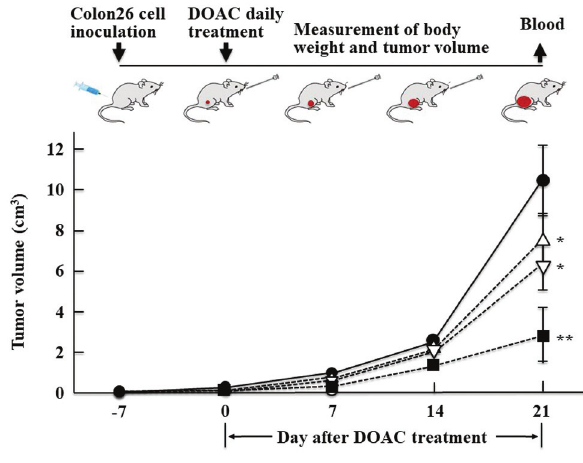
Fig. 2 Effect of direct oral anticoagulants (DOACs) on tumor volume in mice inoculated with Colon26 cells. The general experimental procedure is shown at the top of the fi gure. Mice were inoculated with Colon26 cells, and 7 days later (day 0), DOAC or water was orally administered daily for 21 days. Tumor volumes in Colon26-inoculated mice were measured weekly until day 21; water-treated group ( n ¼ 5) ( ● ), dabigatran etexilate (DABE)-treated group ( n ¼ 5) ( 4 ), rivarox- aban (RVX)-treated group ( n ¼ 5) ( 5 ), edoxaban (EDX)-treated group ( n ¼ 5) ( & ). Data for tumor volumes on day 21 are shown as mean (cid:4) SD. Signi fi cant differences in tumor volume compared with that in the water-treated group of Colon26-inoculated mice are shown as (cid:5) p < 0.05 and (cid:5)(cid:5) p < 0.01.